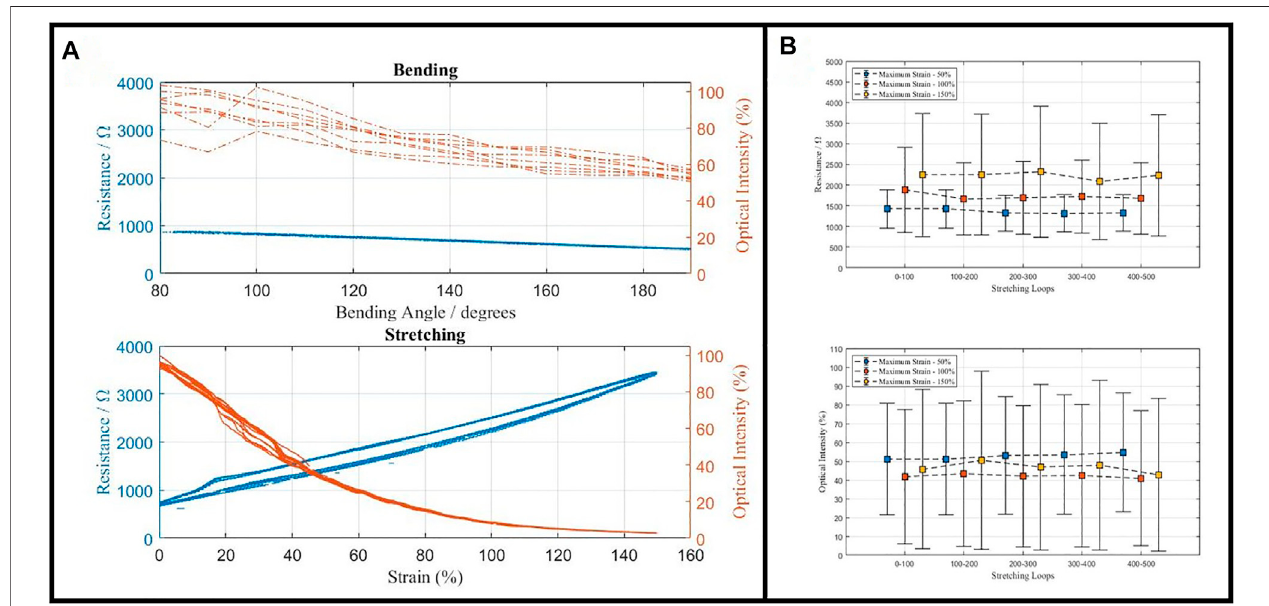
FIGURE 8 | (A) The repetitive tests of the MHS sensor being bended, stretched, and twisted. (B) The duration tests of the MHS sensor, under 50, 100, and 150% stretching strain.